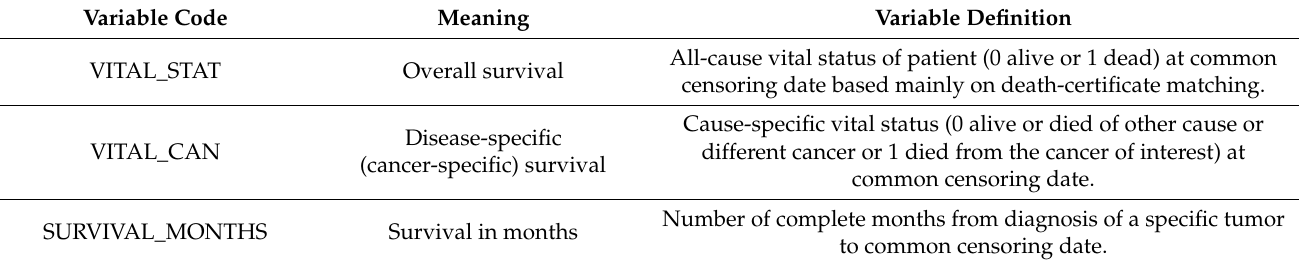
Table 3. Variables regarding patient survival provided by the NCRI.